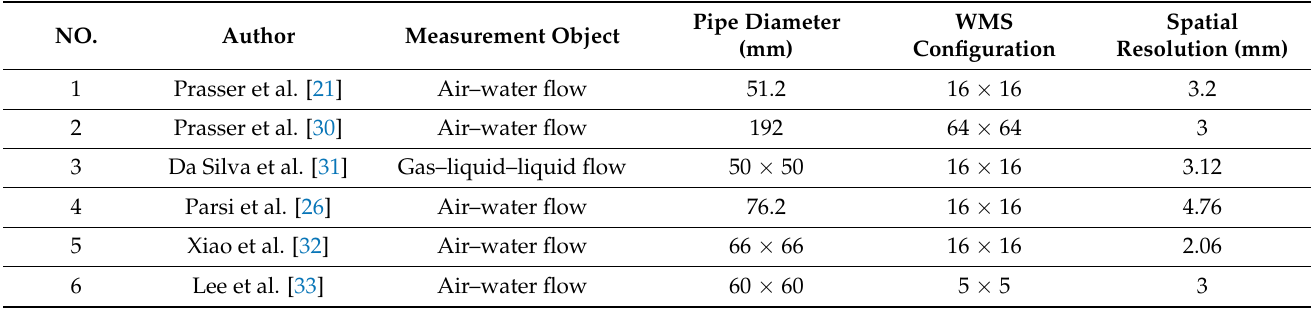
Table 1. WMS configuration and spatial resolution reported in the